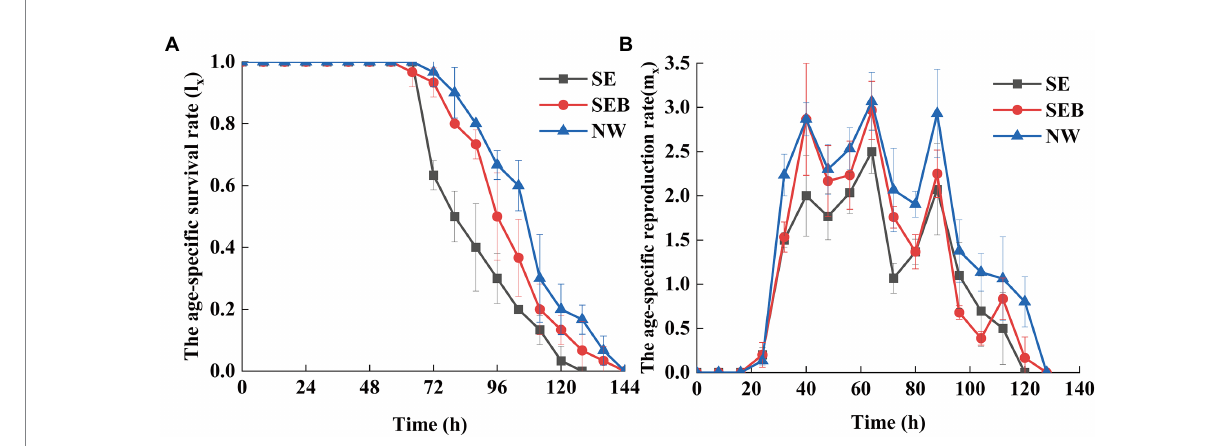
FIGURE 1 The age-specific survival and reproduction curves of Brachionus calyciflorus in different treatmens. (A) The age-specific survival rate. (B) The age- specific reproduction